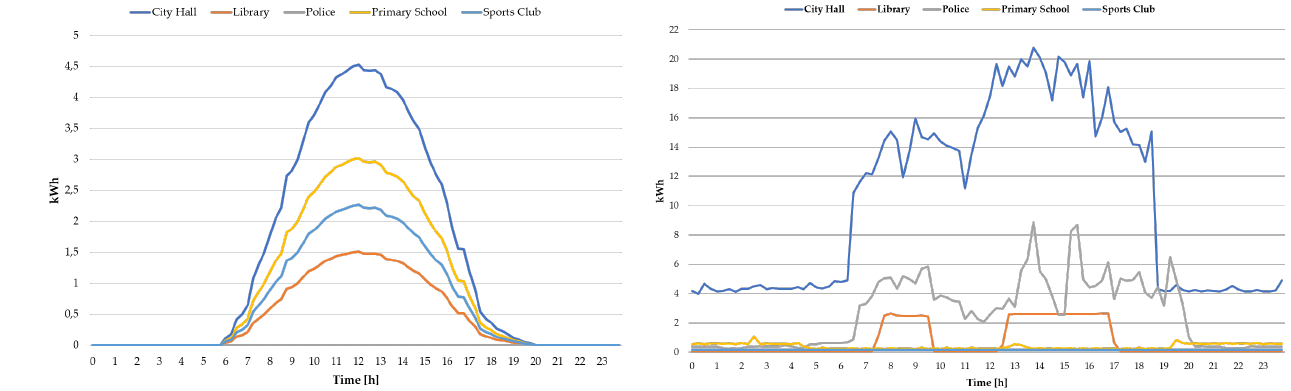
Figure 6. Energy community total generation and consumption.